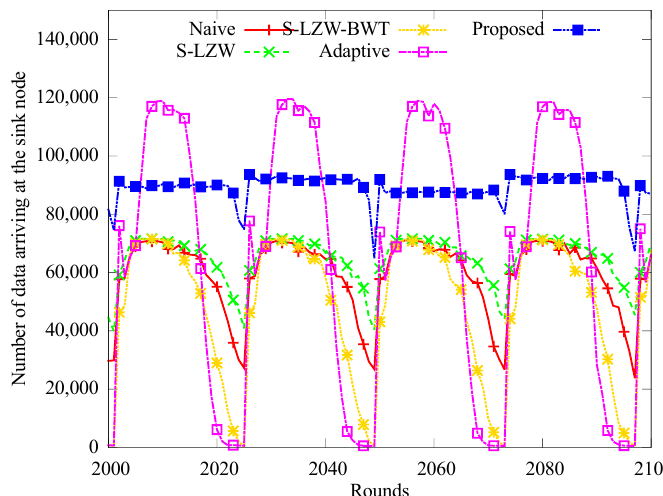
Figure 7. Change in the number of data arriving at the sink node.